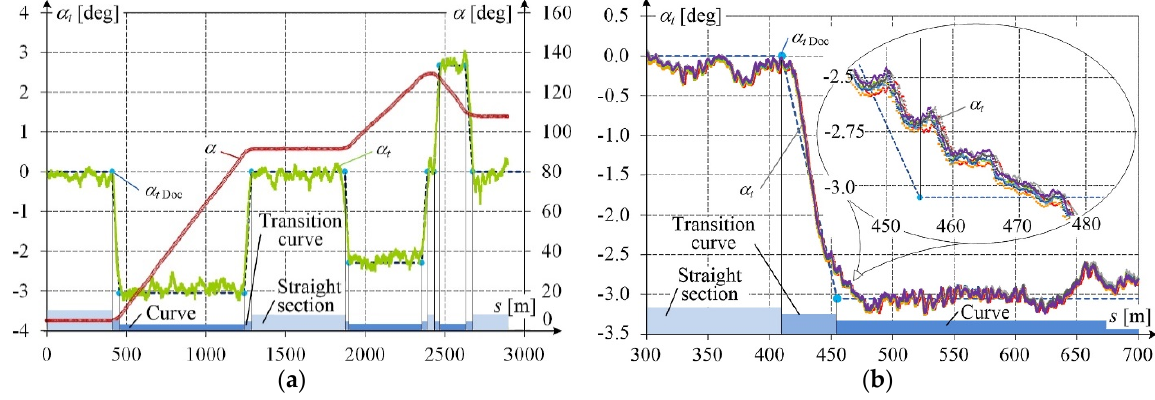
Figure 9. Railway track direction angle obtained from multiple passages: ( a ) entire curve; ( b ) fragment in an expanded scale.